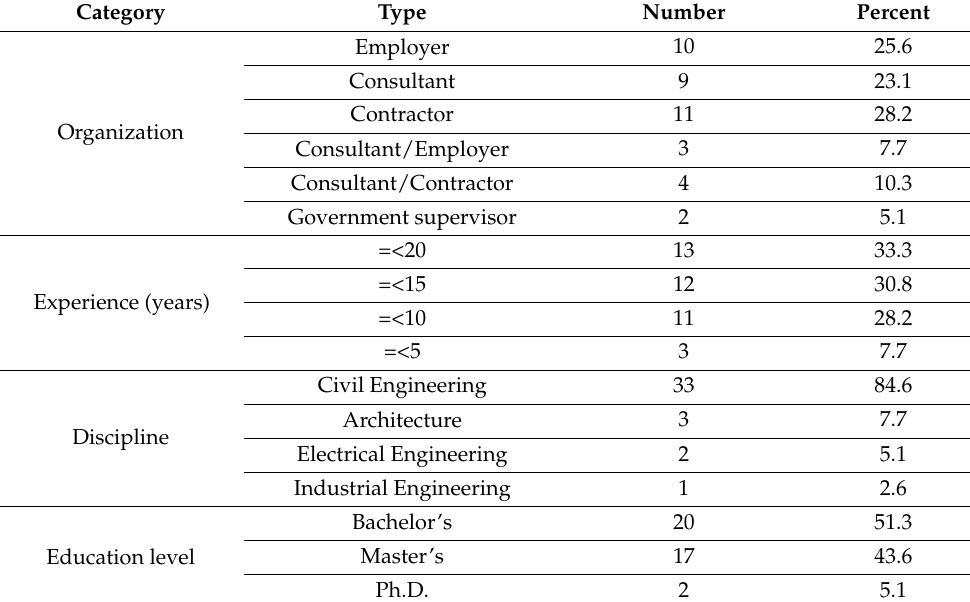
Figure 1. Methodology for developing the proposed cost overrun prediction and cost overrun risk assessment model. Table 2. Respondents’